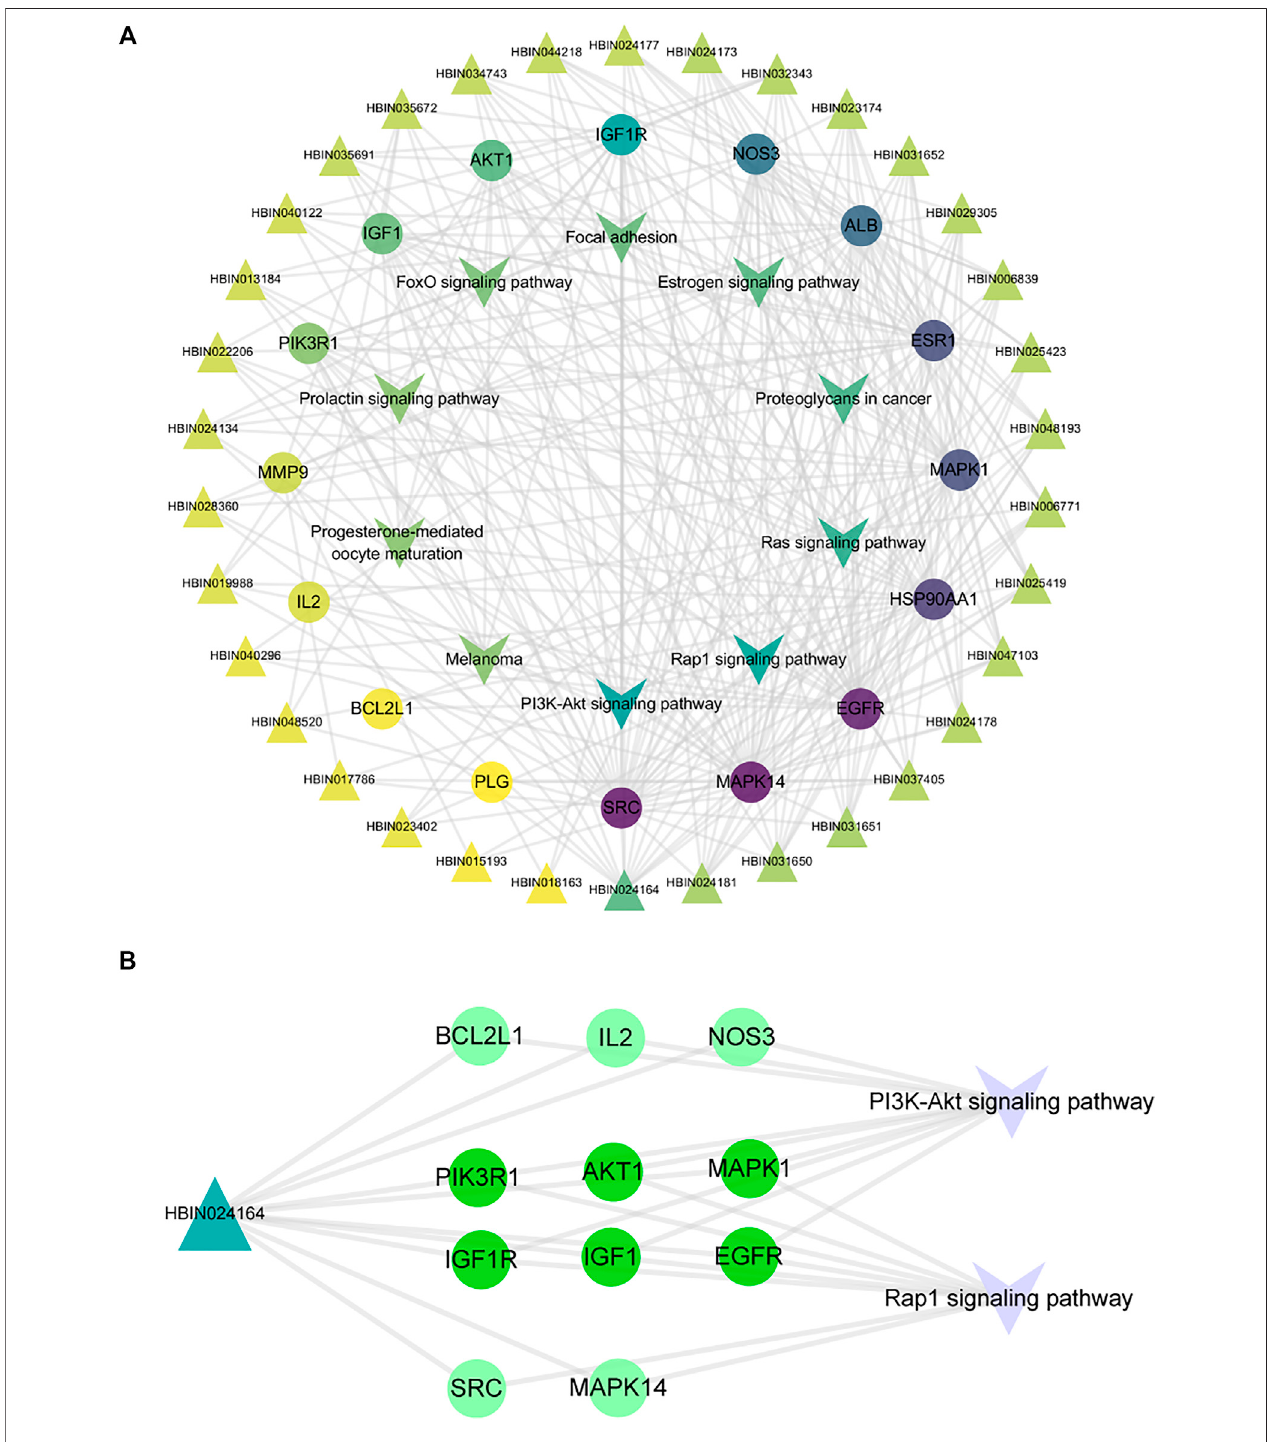
FIGURE 6 | Compound-target-pathway network of DNR against GD. (A) Compound-core-target-pathway network. Triangle nodes represent active compounds, whose colors are proportional to their degree. Circular nodes represent core targets. The nodes color are showed from purple to yellow in descending order of degree values. Inverted triangle nodes represent signaling pathways. (B) The targets of diosgenin enrichment in the PI3K and Rap1 signaling pathways. The dark green targets enriched by diosgenin and two pathways together.